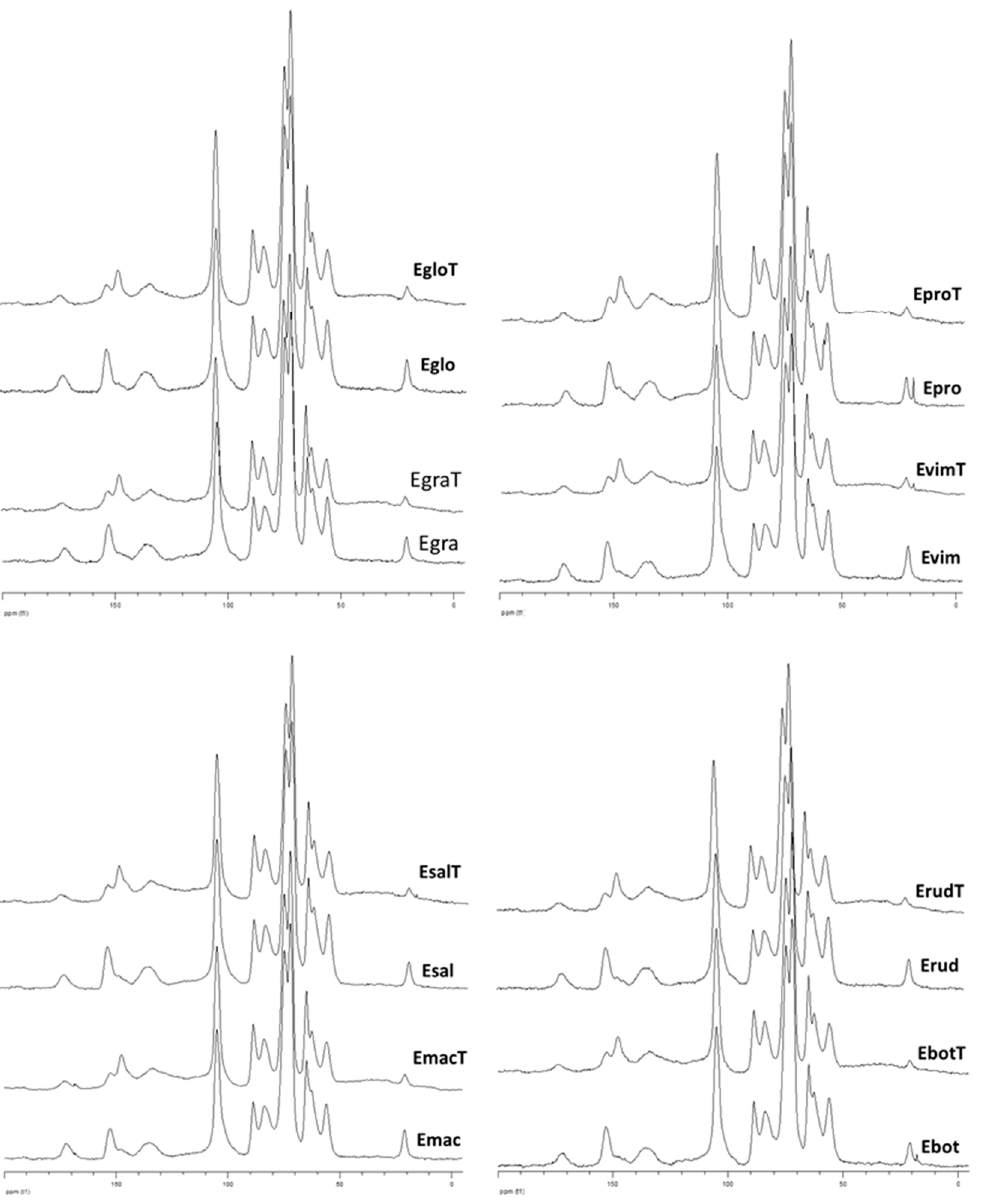
Figure 1. 13 C CP / MAS NMR spectra of the Eucalyptus woods before and after thermal treatment: Figure 1. 13 C CP/MAS NMR spectra of the Eucalyptus woods before and after thermal treatment: E. E. globulus (Eglo / EgloT), E. propinqua (Epro / EproT), E. grandis (Egra / EgraT), E. viminalis (Evim / EvimT), globulus (Eglo/EgloT), E. propinqua (Epro/EproT), E. grandis (Egra/EgraT), E. viminalis (Evim/EvimT), E. saligna (Esal / EsalT), E. rudis (Erud / ErudT), E. maculata (Emac / EmacT), E. botryoides (Ebo / E. saligna (Esal/EsalT), E. rudis (Erud/ErudT), E. maculata (Emac/EmacT), E. botryoides (Ebo/EboT).